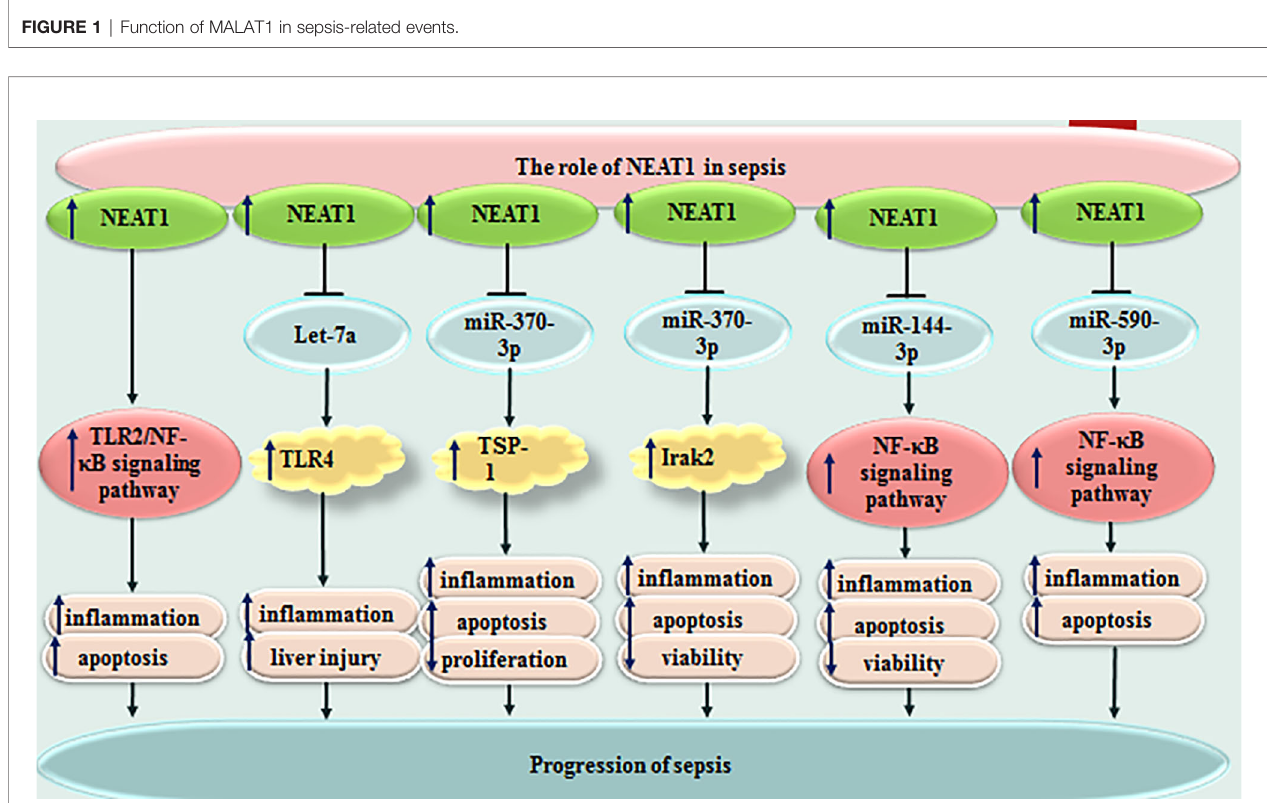
FIGURE 2 | Function of NEAT1 in sepsis-related events. Several other lncRNAs have also been found to in fl uence course of sepsis through modulation of immune responses ( Table 1 ).